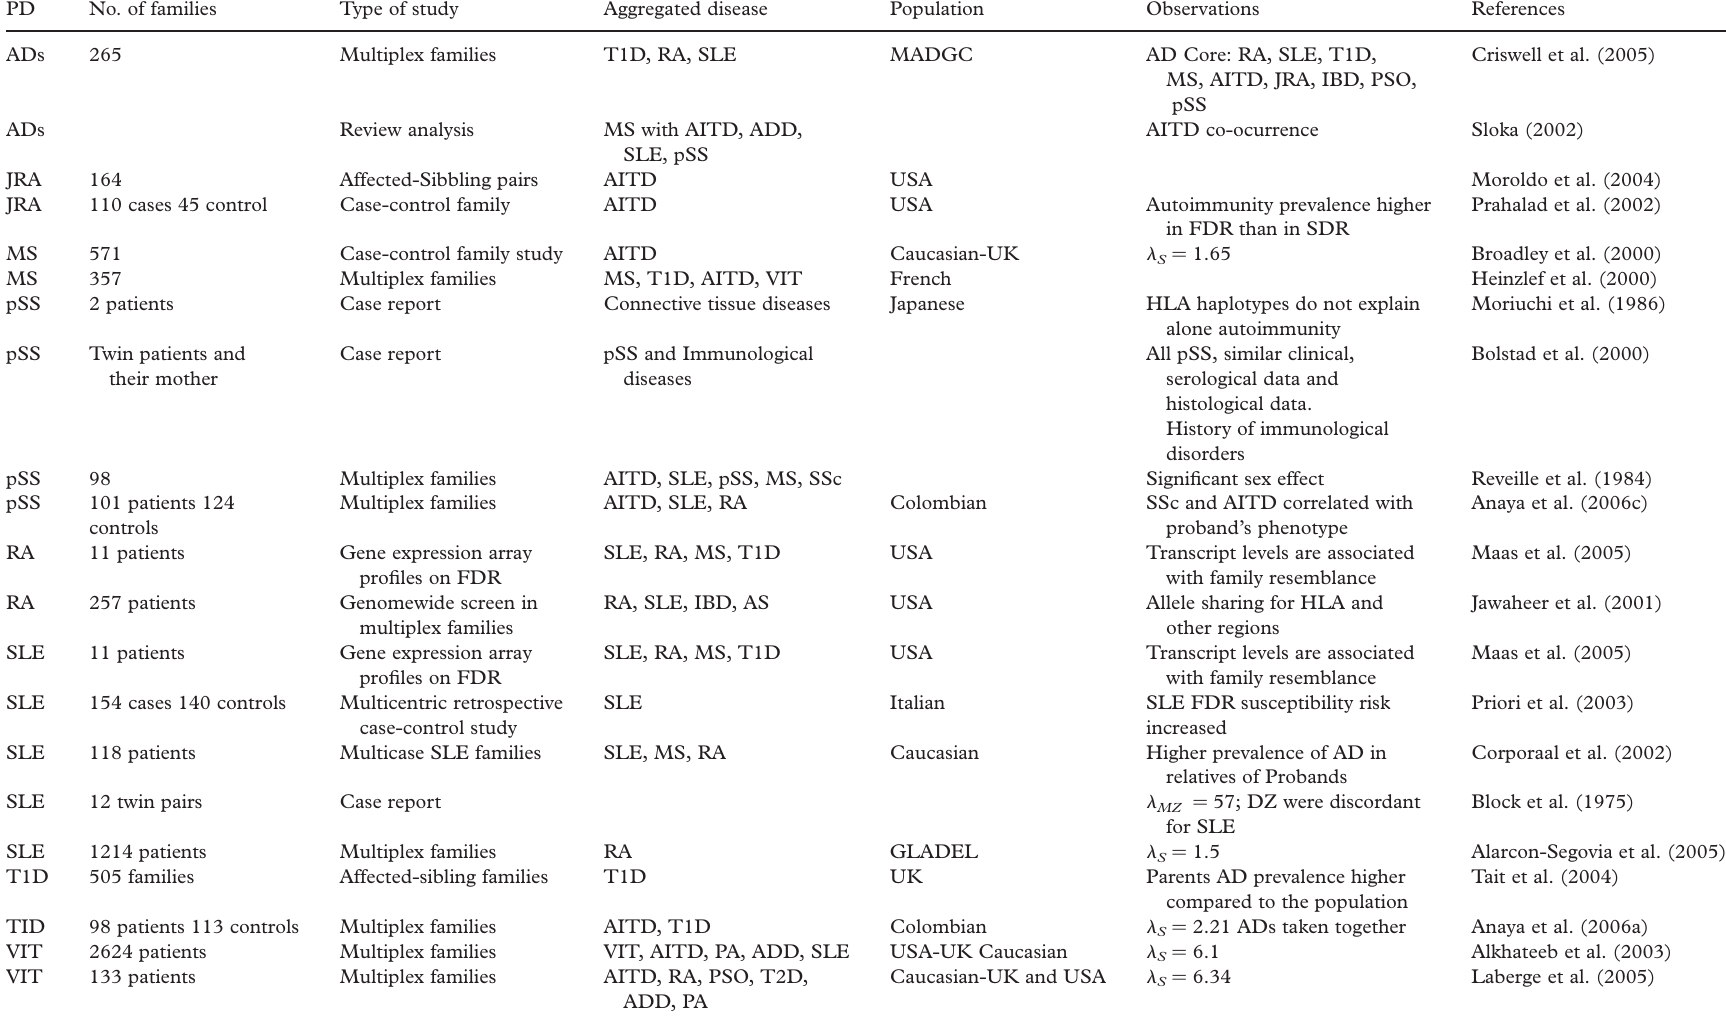
Table I. Main familial autoimmunity